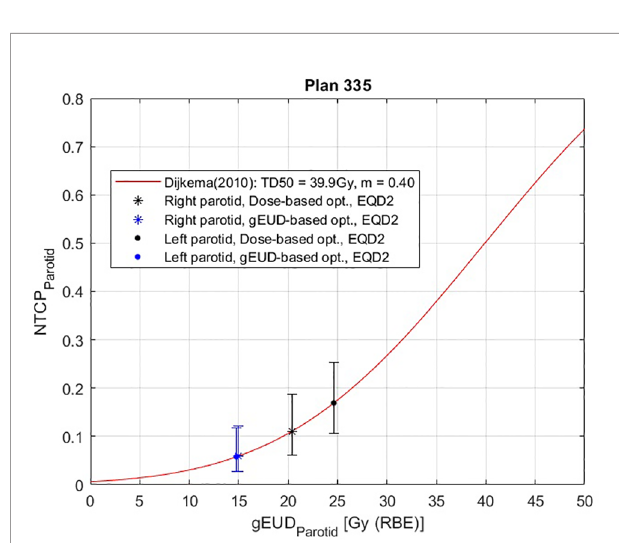
FIGURE 10 | Normal tissue complication probability (NTCP) curve for the parotid glands of patient plan 335, calculated according to Lyman – Kutcher – Burman (LKB) model, using the parameters obtained by Dijkema et al. (29). The error bars were calculated as before. A therapeutic plan of 20 fractions of 3 Gy is considered, with EQD2